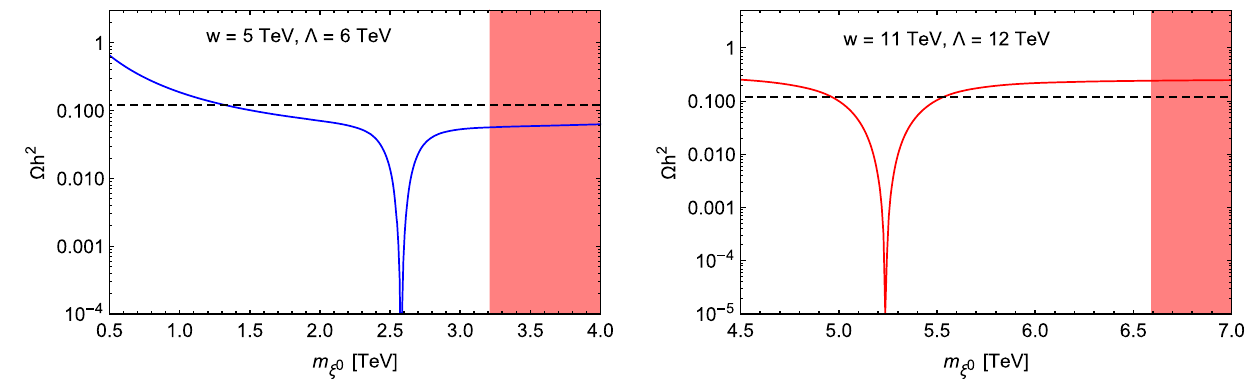
Fig. 8 The relic density of the fermion candidate as a function of its mass according to the several choices of w,(cid:11) , where the DM unstable region is input as light